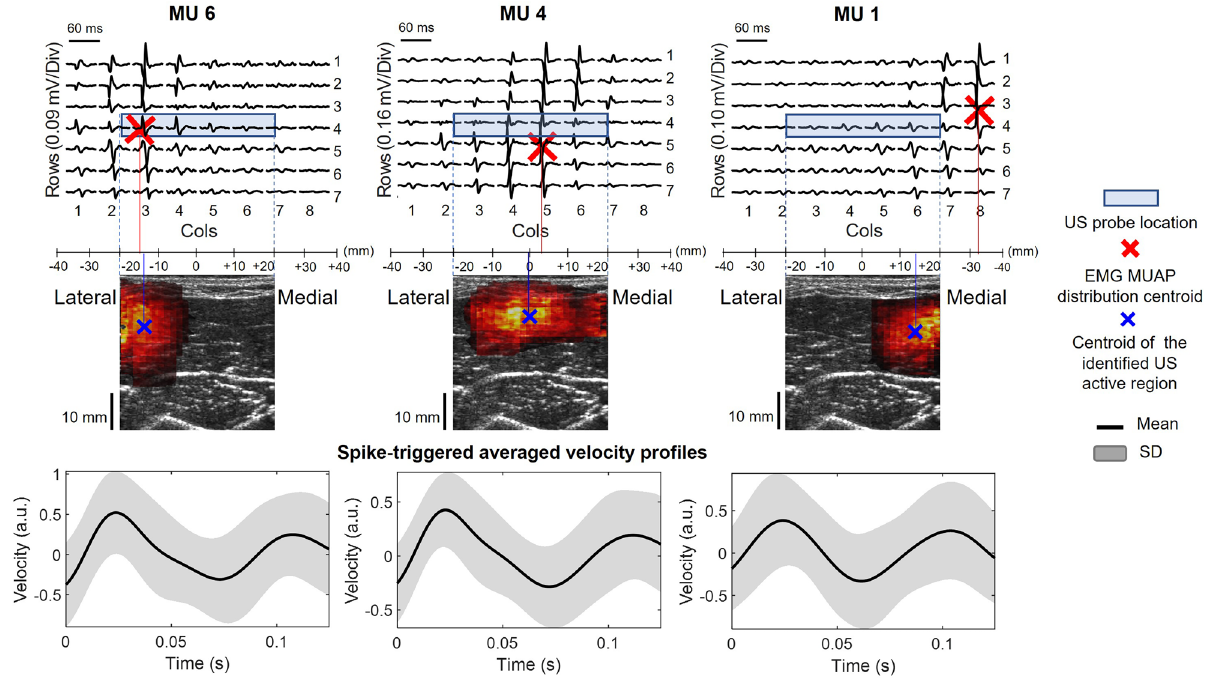
Figure 4. Example of three MUs from biceps brachii during a 2% isometric contraction in one representative subject. From top to bottom: MUAPs decomposed from HDsEMG with the correspondent centroids (red crosses); identified MU spatial representation overlapped on the B-mode images of BB with correspondent centroids (blue crosses); means (black solid line) and the standard deviation (grey band) of the spike-triggered averaged velocity profiles related to the correspondent identified